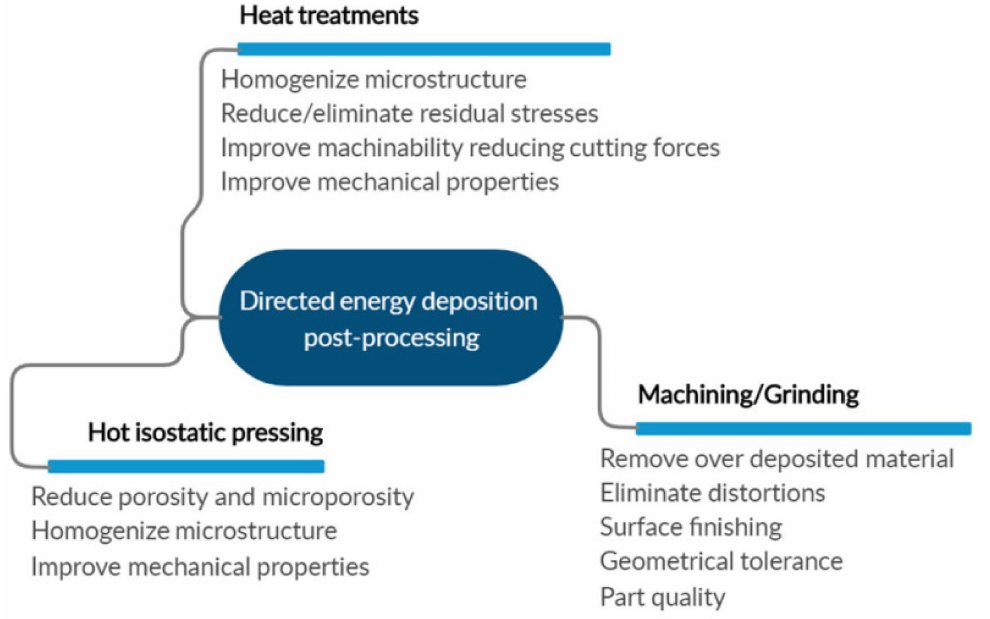
Figure 11. Post-processing techniques used to overcome the limitations of parts fabricated by direct energy deposition (DED) [110].